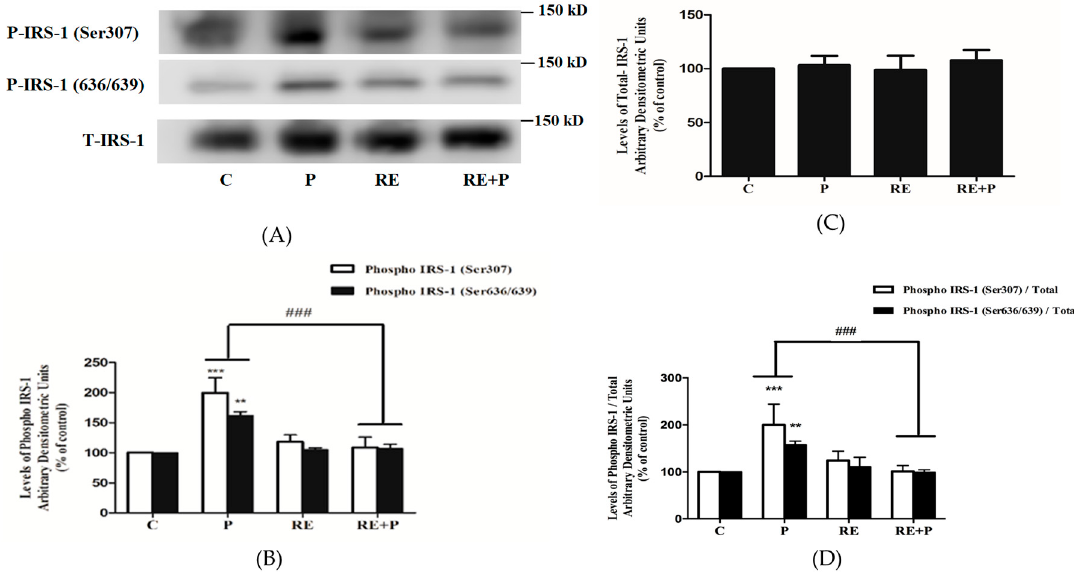
Figure 3. Effects of palmitate and RE on IRS-l expression and Ser307, Ser636/639 phosphorylation. Fully differentiated myotubes were treated without (control, C) or with 0.2 mM palmitate (P) in the absence or the presence of 5 µ g/mL RE for 16 h. After treatment, the cells were lysed, and sodium dodecyl sulfate polyacrylamide gel electrophoresis (SDS-PAGE) was performed, followed by immunoblotting with specific antibodies that recognize phosphorylated (Ser307, Ser636/639) or total IRS-1 (T-IRS-1). Representative immunoblots are shown ( A ). The densitometry of the bands was measured and expressed in arbitrary units ( B – D ). The data are the mean ± SE of three separate experiments (*** p < 0.001, ** p < 0.01 vs. control, ### p < 0.001 vs. palmitate alone).